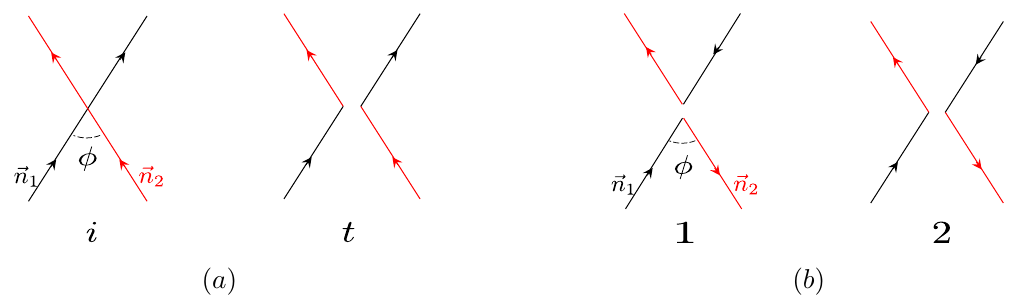
Figure 13 . ( a ) Intersecting lines (denoted by i ) and \touching" lines (denoted by t ). They are characterized by a geometrical angle (cid:30) and mix under the renormalization. In N = 4 SYM, we can consider the generalization of these lines which couple also to scalars. In that case, the black lines couple to ~n 1 (cid:1) ~ (cid:8) and the red lines couple to ~n 2 (cid:1) ~ (cid:8). This introduces an additional angle cos (cid:18) = ~n 1 (cid:1) ~n 2 . ( b ) Two touching con(cid:12)gurations (1 and 2) whose cross anomalous dimension will be computed